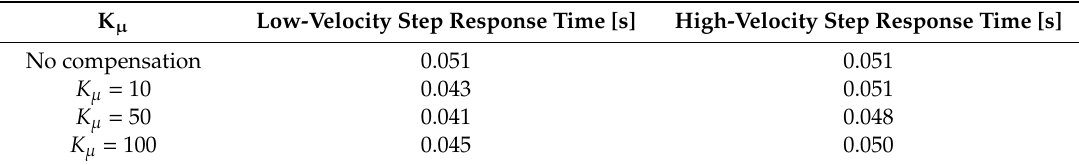
Table 4. Motor velocity step response time.